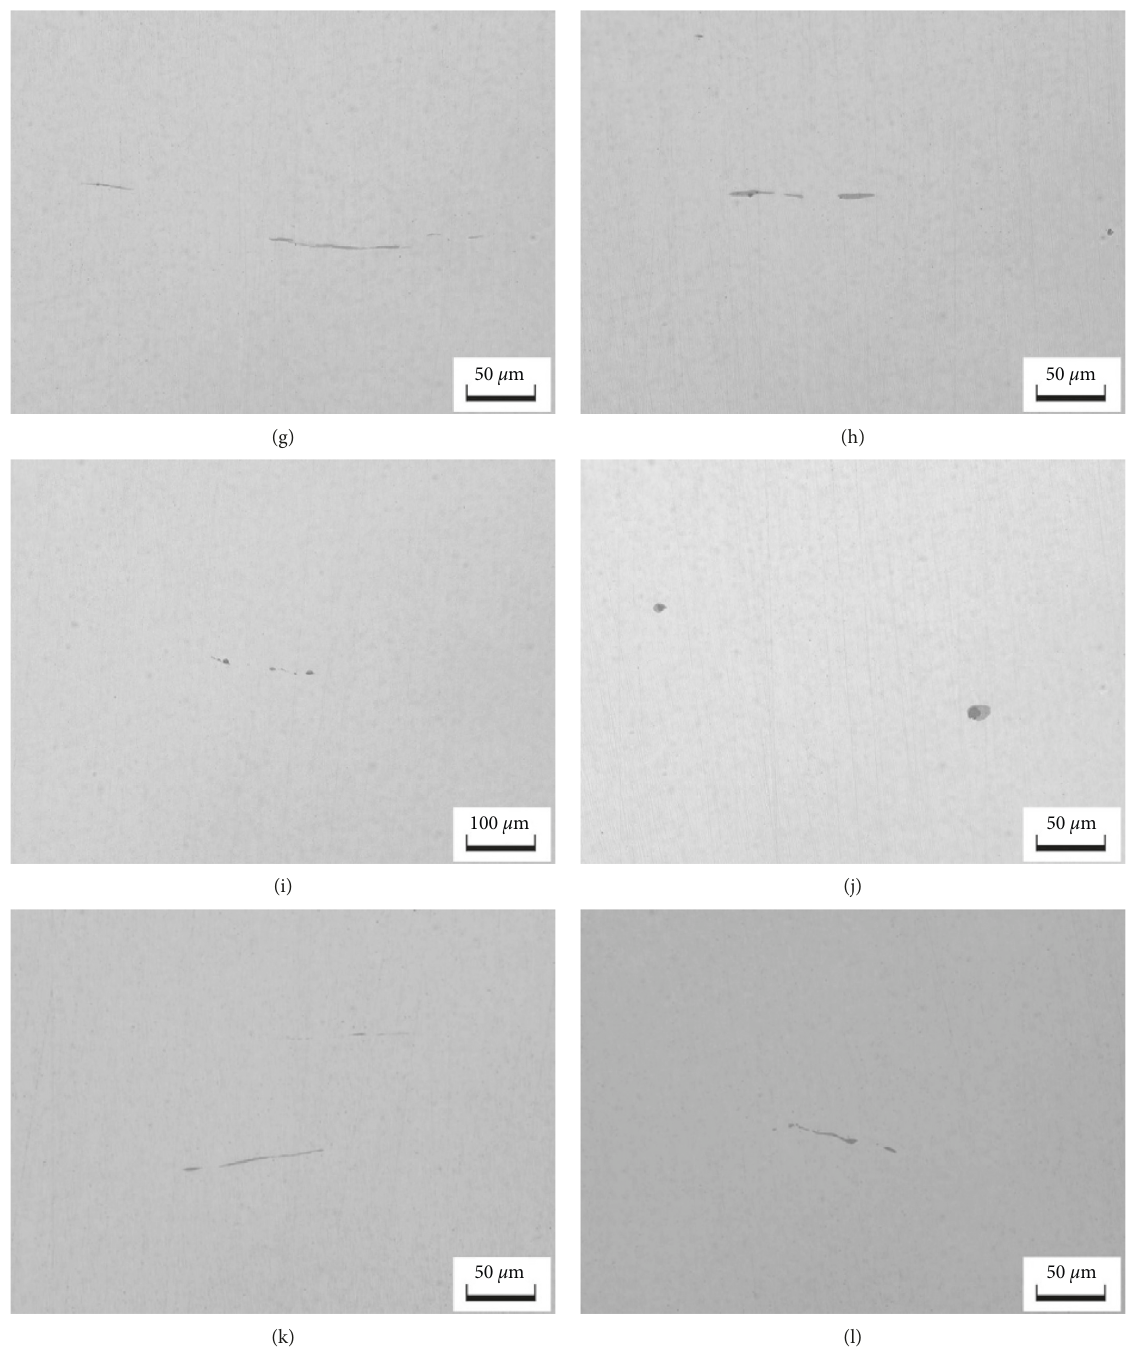
Figure 8: Sulfide and oxide inclusions. (a) Sulfide inclusions in sample X -2. (b) Local enlargement of Figure 8(a). (c) Sulfide inclusions in sample X -2. (d) Sulfide inclusions in sample X -2. (e) Oxide inclusions in sample X -2. (f) Oxide inclusions in sample X -2. (g) Sulfide inclusions in sample X -4. (h) Sulfide inclusions in sample X -4. (i) Oxide inclusions in sample X -2. (j) Composite oxide inclusions in sample X -4. (k) Sulfide inclusions in sample Y -2. (l) Sulfide inclusions in sample Y